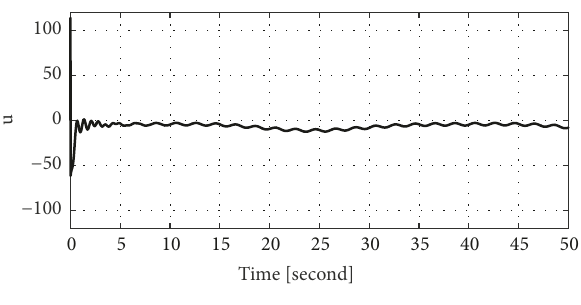
Figure 5: Control input.